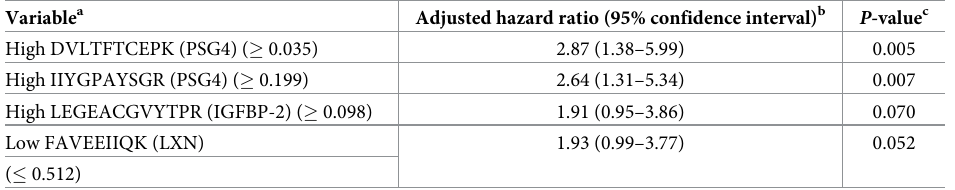
Table 5. Cox proportional hazards analysis of cerclage-to-delivery